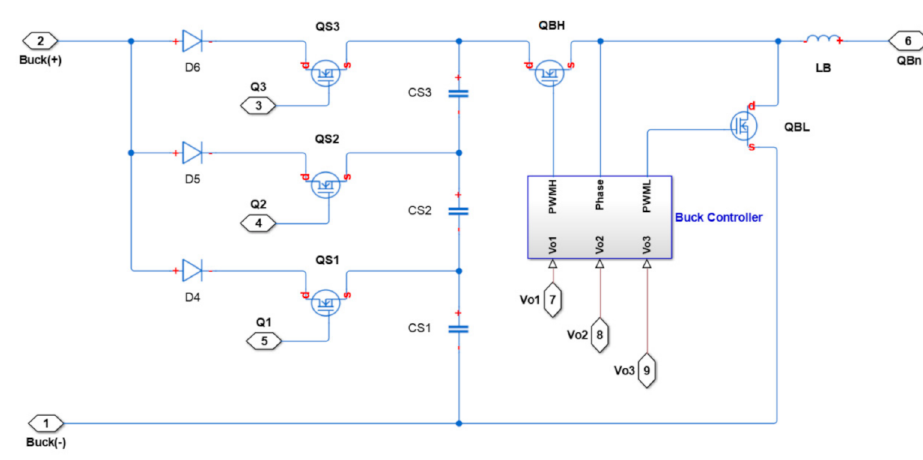
Figure 16. Expanded view of SIMO buck converter showed in Figure